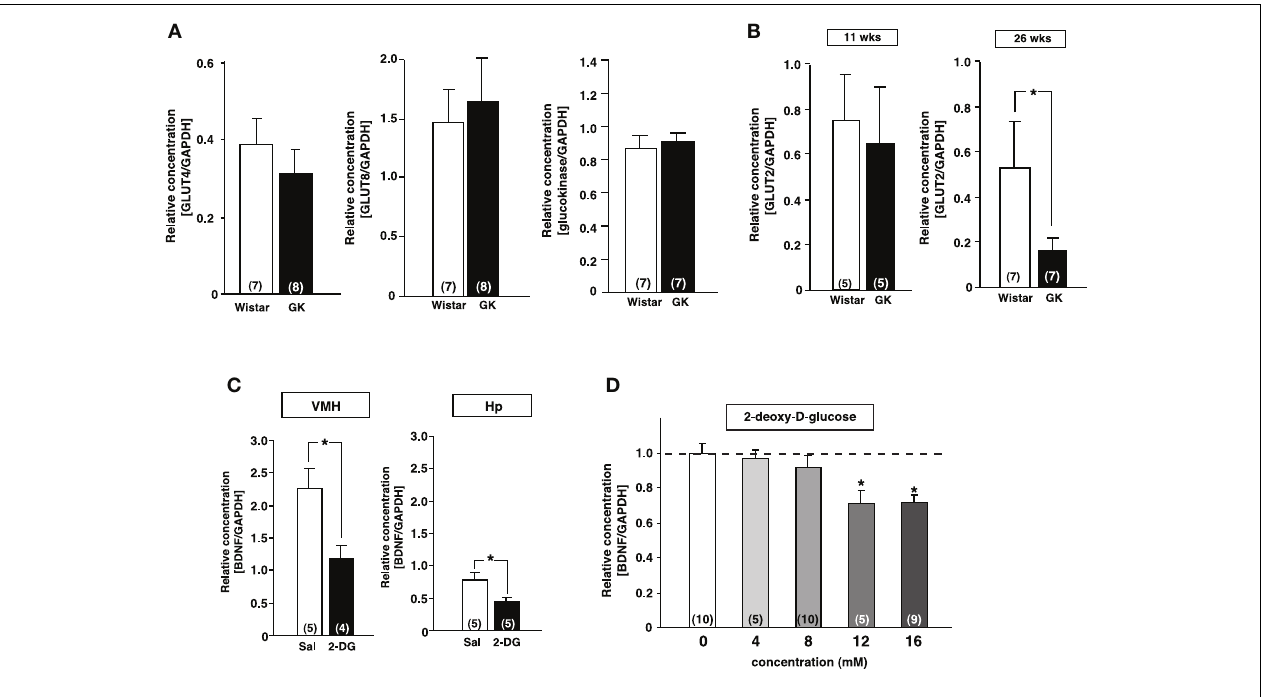
FIGURE 3 | Reduction of GLUT2 paralleled with reduction of BDNF expression in GK rats. (A) GLUT4, GLUT8 and gluokinase mRNA expressions in VMH were unchanged in GK rats at 26 weeks. (B) GLUT2 mRNA expression in VMH was significantly reduced in GK rats at 26 weeks, but not at 11 weeks ( ∗ p < 0 . 05, Student’s t -test). (C) Effects of icv 2-DG injection on BDNF mRNA levels in VMH were determined at 2h after icv